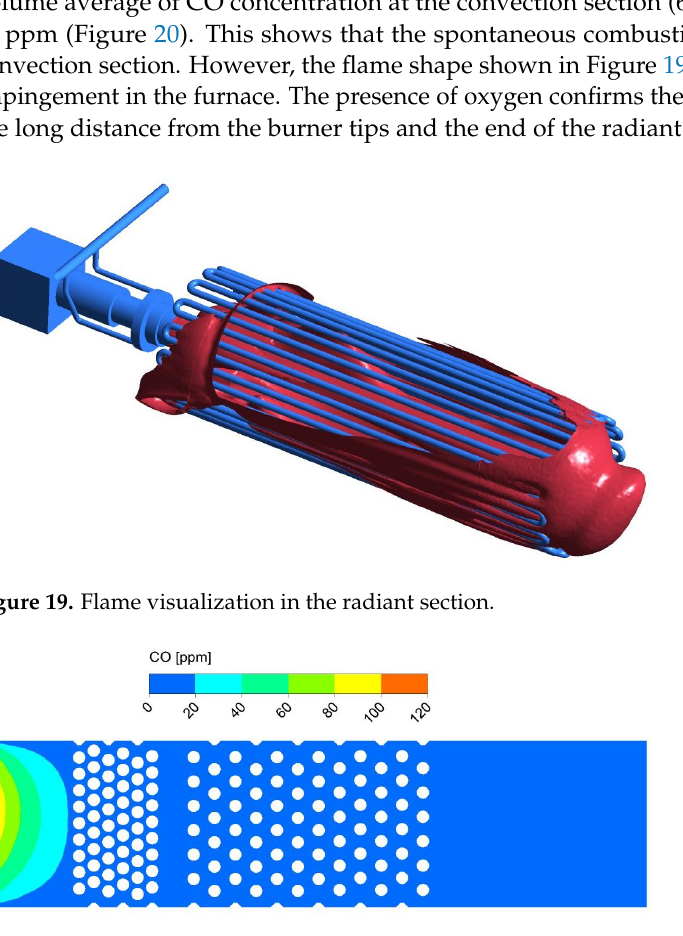
Figure 20. CO concentration distribution in the convection section-[CO] volume average = 6.84